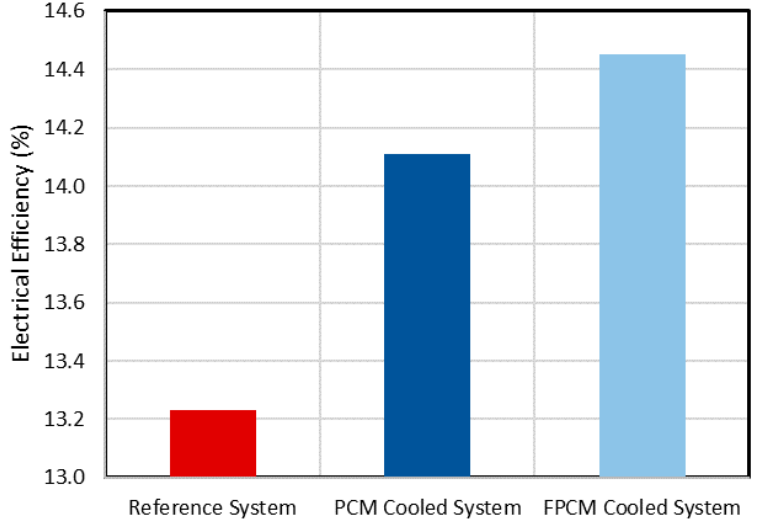
Figure 8. Electrical efficiency of reference system, PCM cooled and FPCM cooled system around noon.